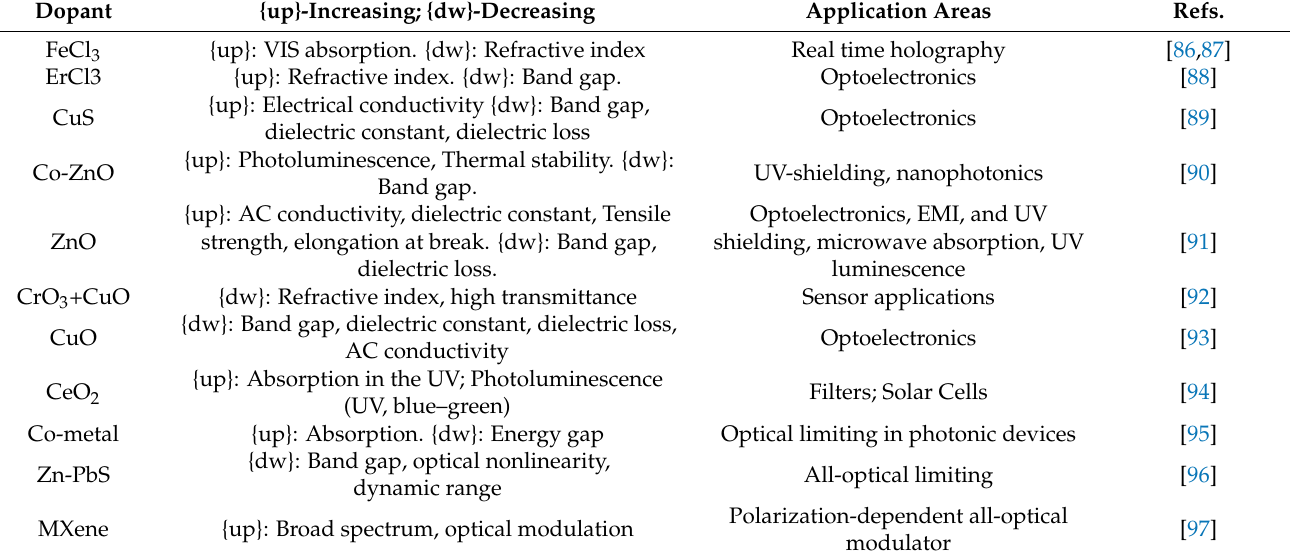
Table 2. Effect of different dopants on optical and electrical properties of PVA. Application Areas